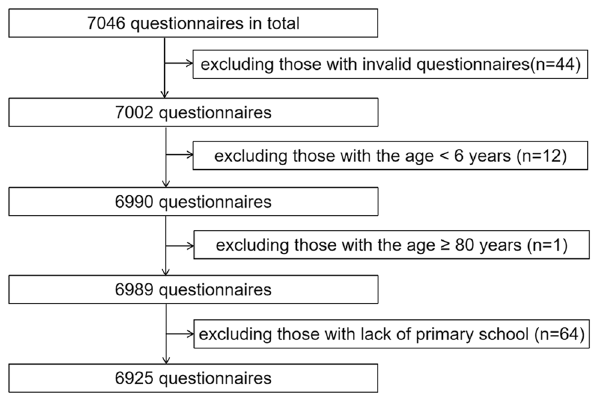
Figure 2. Flow chart of questionnaire selection.